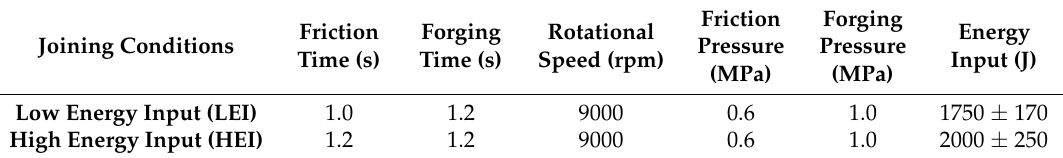
Table 3. Joining conditions and calculated energy input for the specimens investigated in this work.